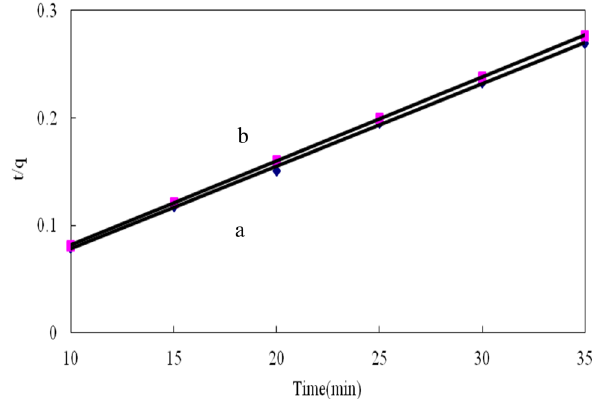
Fig. 2 Pseudo-second-order kinetic simulation; 7.5 g/l of MCM-41, T = 25 °C, pH = 4.5; a Pb 2+ : 1 mg/ml; b Pb 2+ : 4 mg/ml